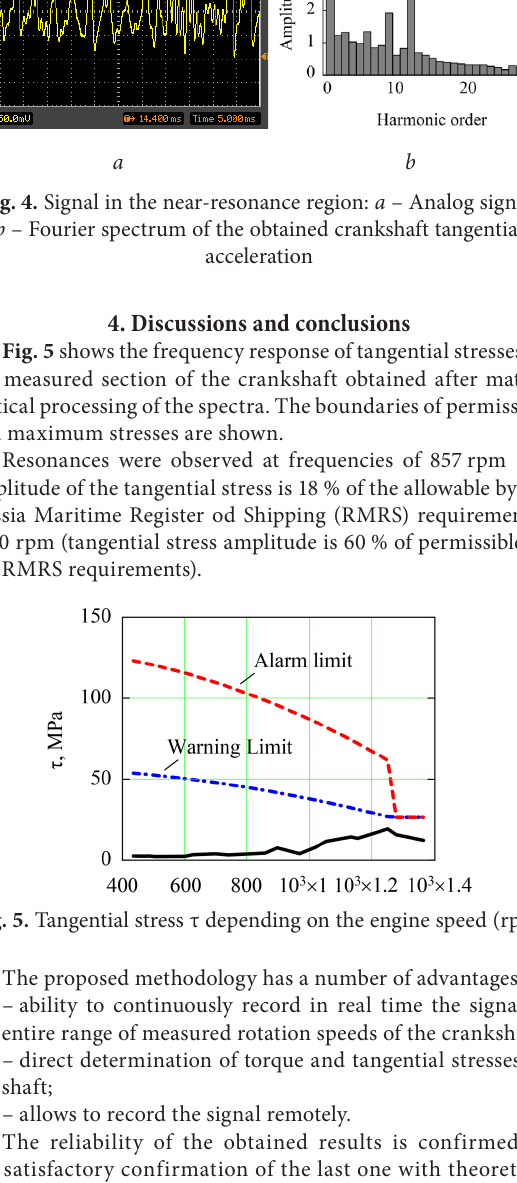
Fig. 3. Characteristics of the receiving and transmitting: a – Noise; b – amplitude-frequency characteristic of the receiving and transmitting